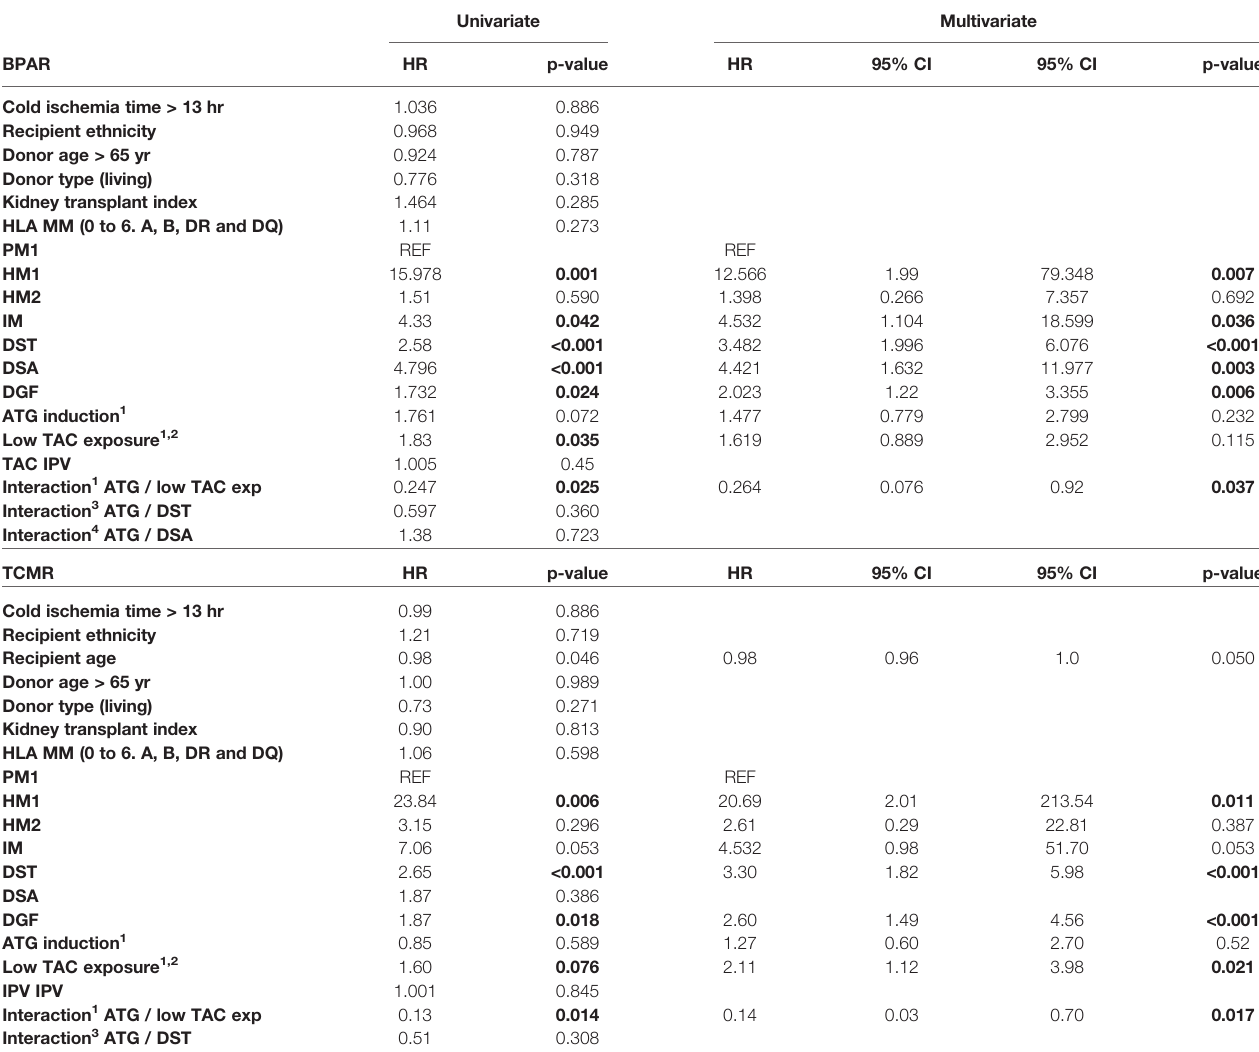
TABLE 3 | Univariate and Multivariate Cox analyses for clinical and immunological variables associated with the risk of